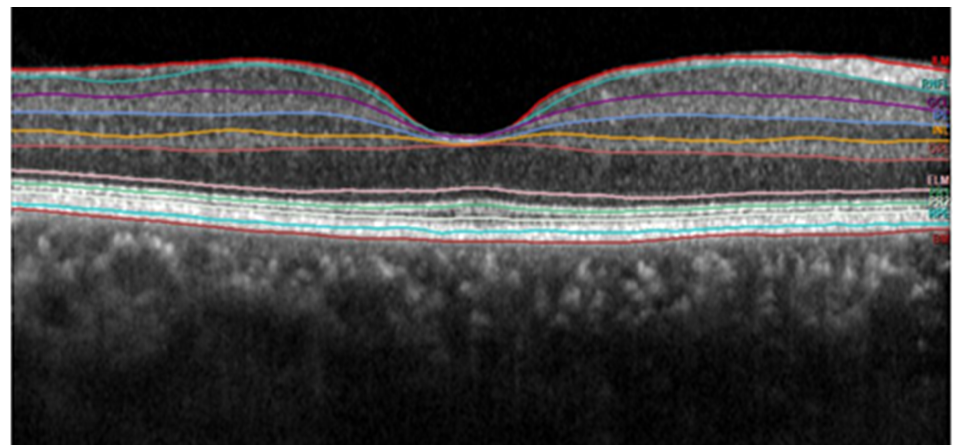
Figure 13. Subretinal layer segmentation of macular OCT.